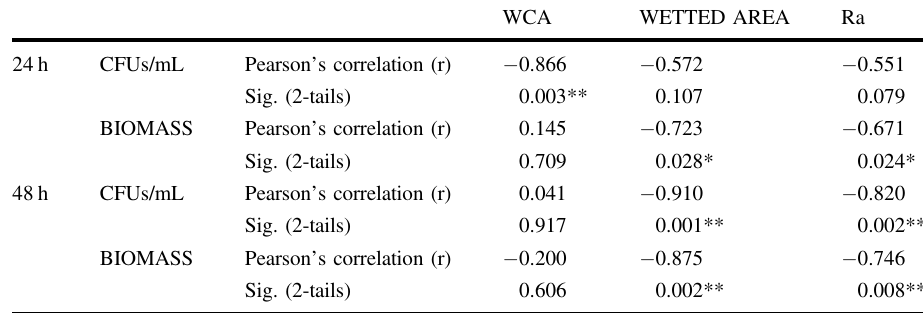
Table 1 The values of the Pearson ’ s correlation of the parameters analyzed in the